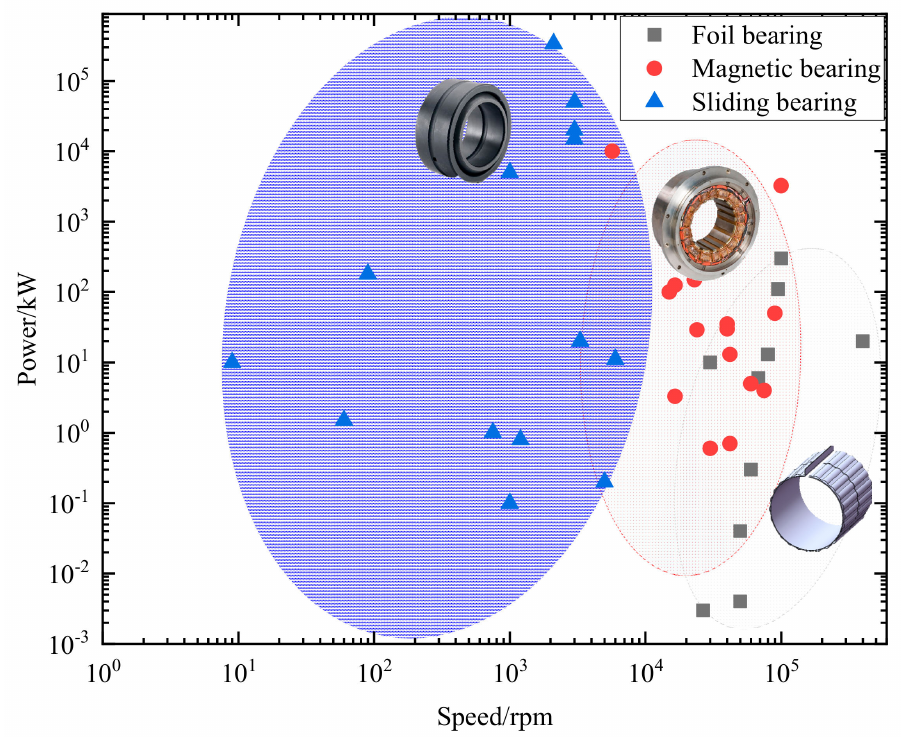
Figure 1. Application range of different kinds